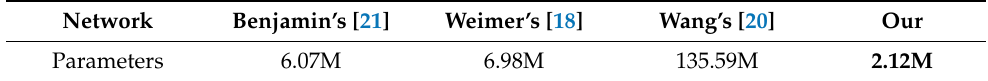
Table 5. Parameters of di ff erent